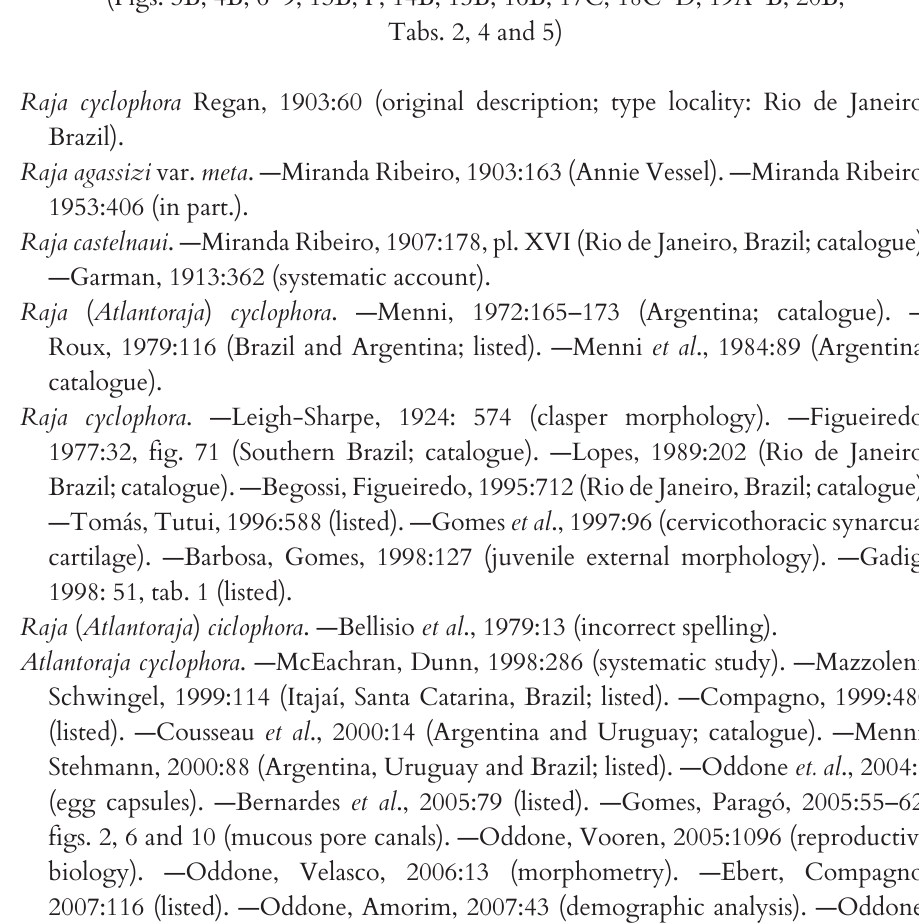
(Figs. 3B, 4B, 6–9, 13B, F, 14B, 15B, 16B, 17C, 18C–D, 19A–B, 20B; Tabs. 2, 4 and